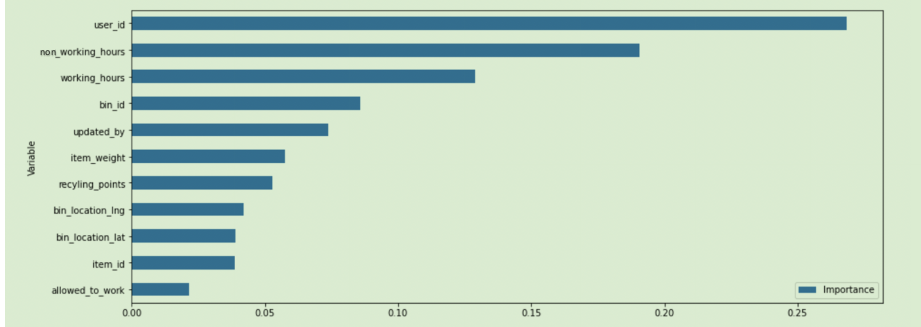
Figure 12. Variable importance for the optimal